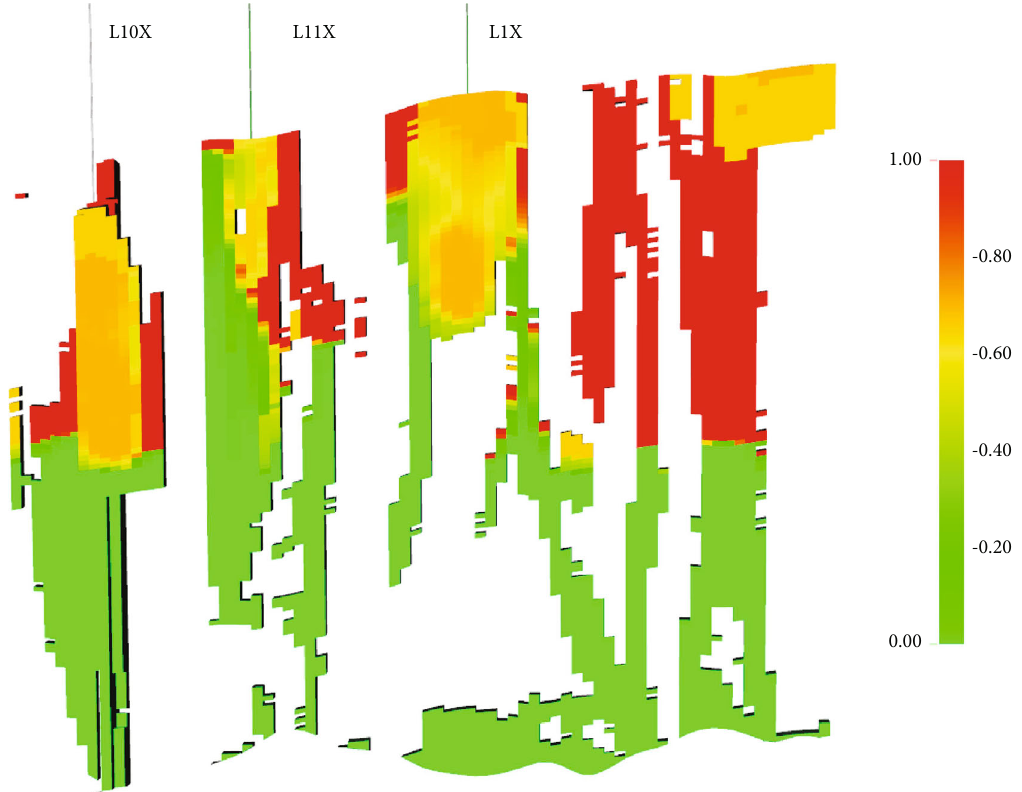
Figure 13: Residual oil distribution between L10X and L11X wells.